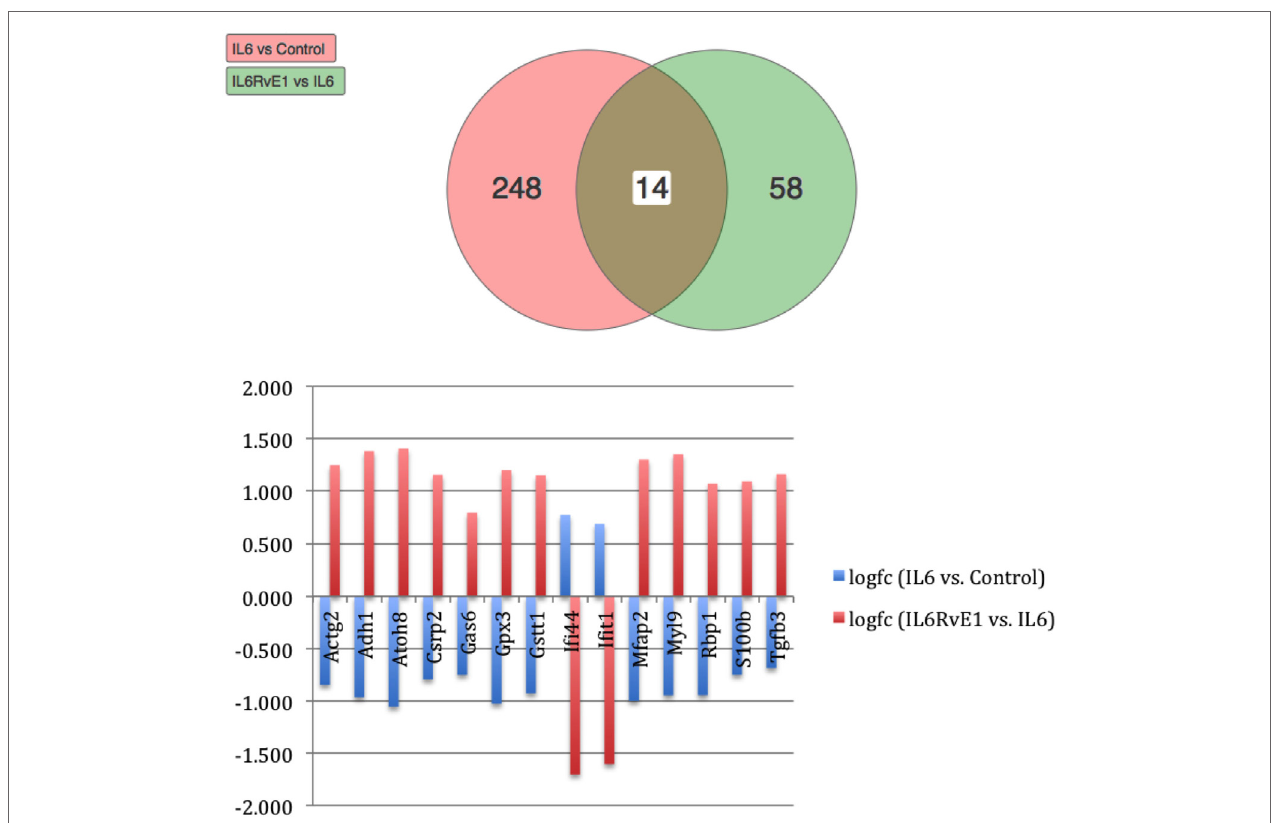
FigUre 8 | Meta analysis of differential gene expression. We identified a group of 14, which were significantly differentiated (upregulated/downregulated) genes after induction of inflammation and were significantly reversed after treatment with resolvin E1 (RvE1). For a list of genes and their functions see Tables 1 and 2